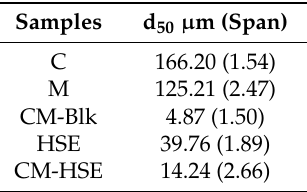
Table 2. Dimensional distribution (d 50 ) of raw materials and spray-dried systems.